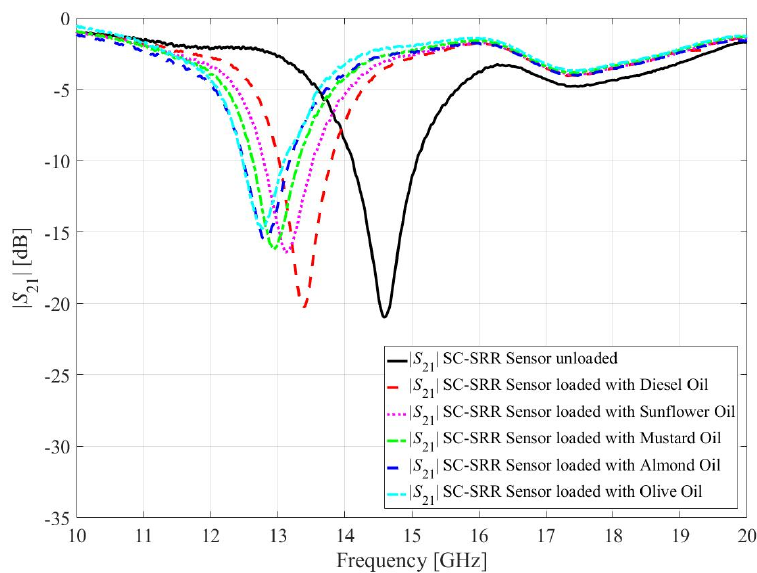
Figure 14. Calibration model of the proposed sensor. Circles correspond to the MUT measurement data in Table 3. Horizontal bars represent the standard deviations of the measurement data.